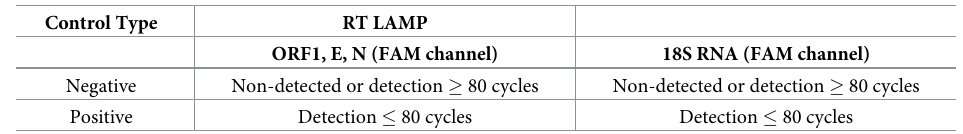
For each sample, four reactions were prepared: two replicates were prepared to detect SARS-CoV-2 and two for the detection of 18S RNA. Samples were loaded into a 384-well plate (cat#4309849 Thermo Fisher Scientific), sealed with optical adhesive film (cat# 4311971 Fisher Scientific), and centrifuged at 1000 rpm for 1 minute. The QuantStudio ™ 5 was used to set up the reaction as follows: 100 cycles (each cycle of 30 seconds incubated at 65 degrees Celsius) were selected as PCR steps (on the FAM channel), and data collection was set to ON (for data Table 2. Cut-off